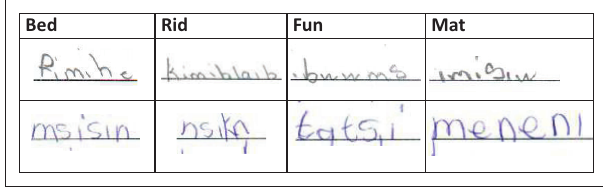
FIGURE 6: Alphabetical.